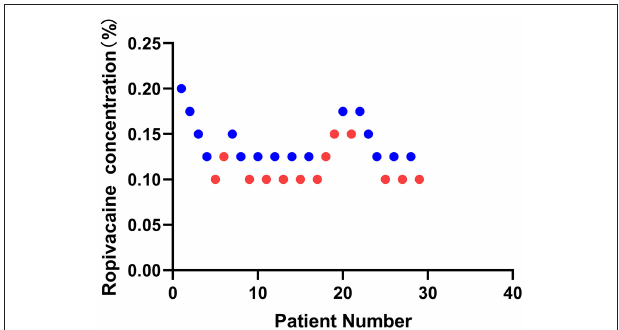
FIGURE 2 | Sequential block results of ultrasound-guided sciatic nerve block using 20ml ropivacaine according to the Dixon and Massey up-and-down